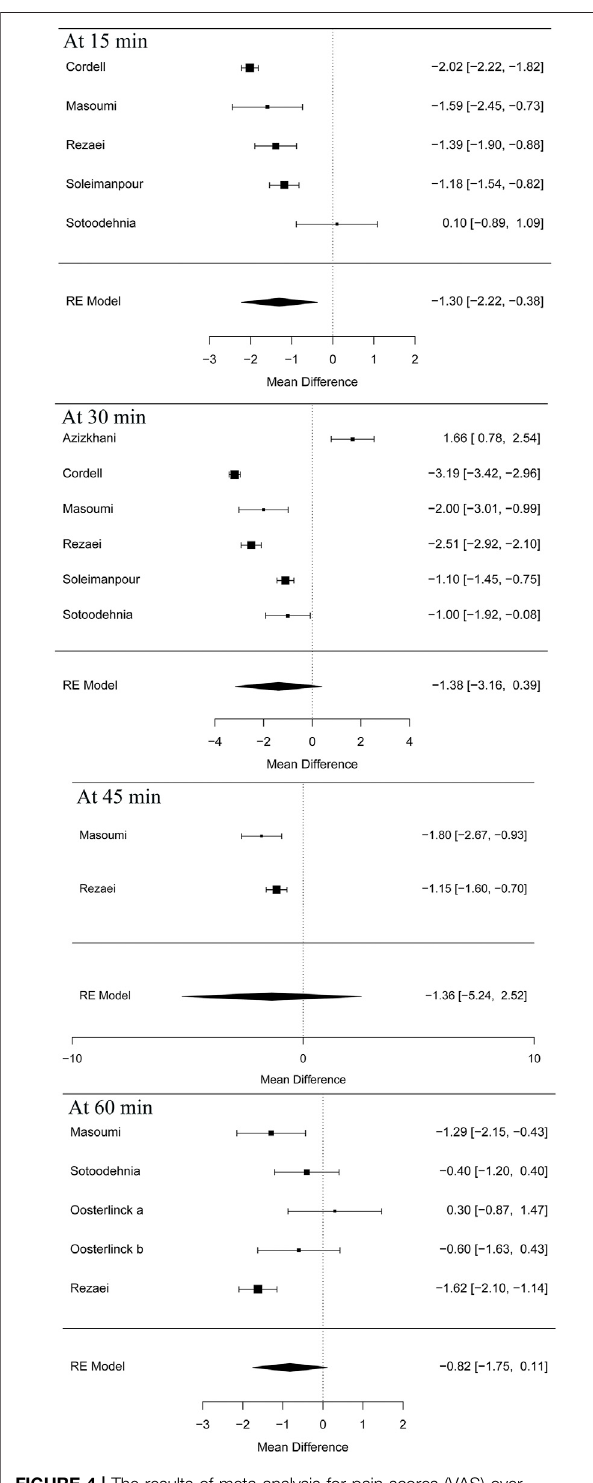
FIGURE 4 | The results of meta-analysis for pain scores (VAS) over different time periods.